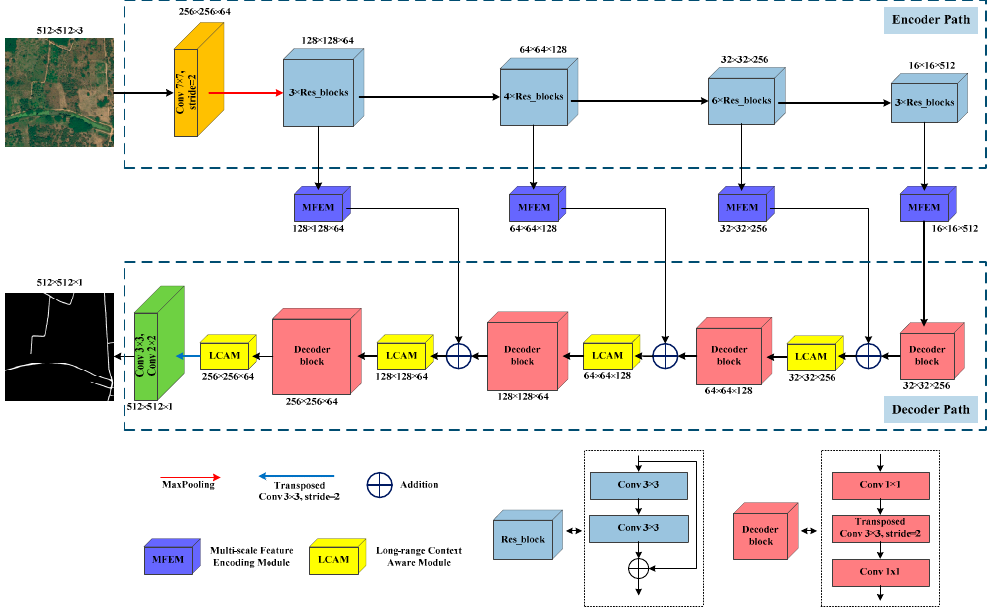
Figure 1. The overall structure of the proposed MECA-Net.